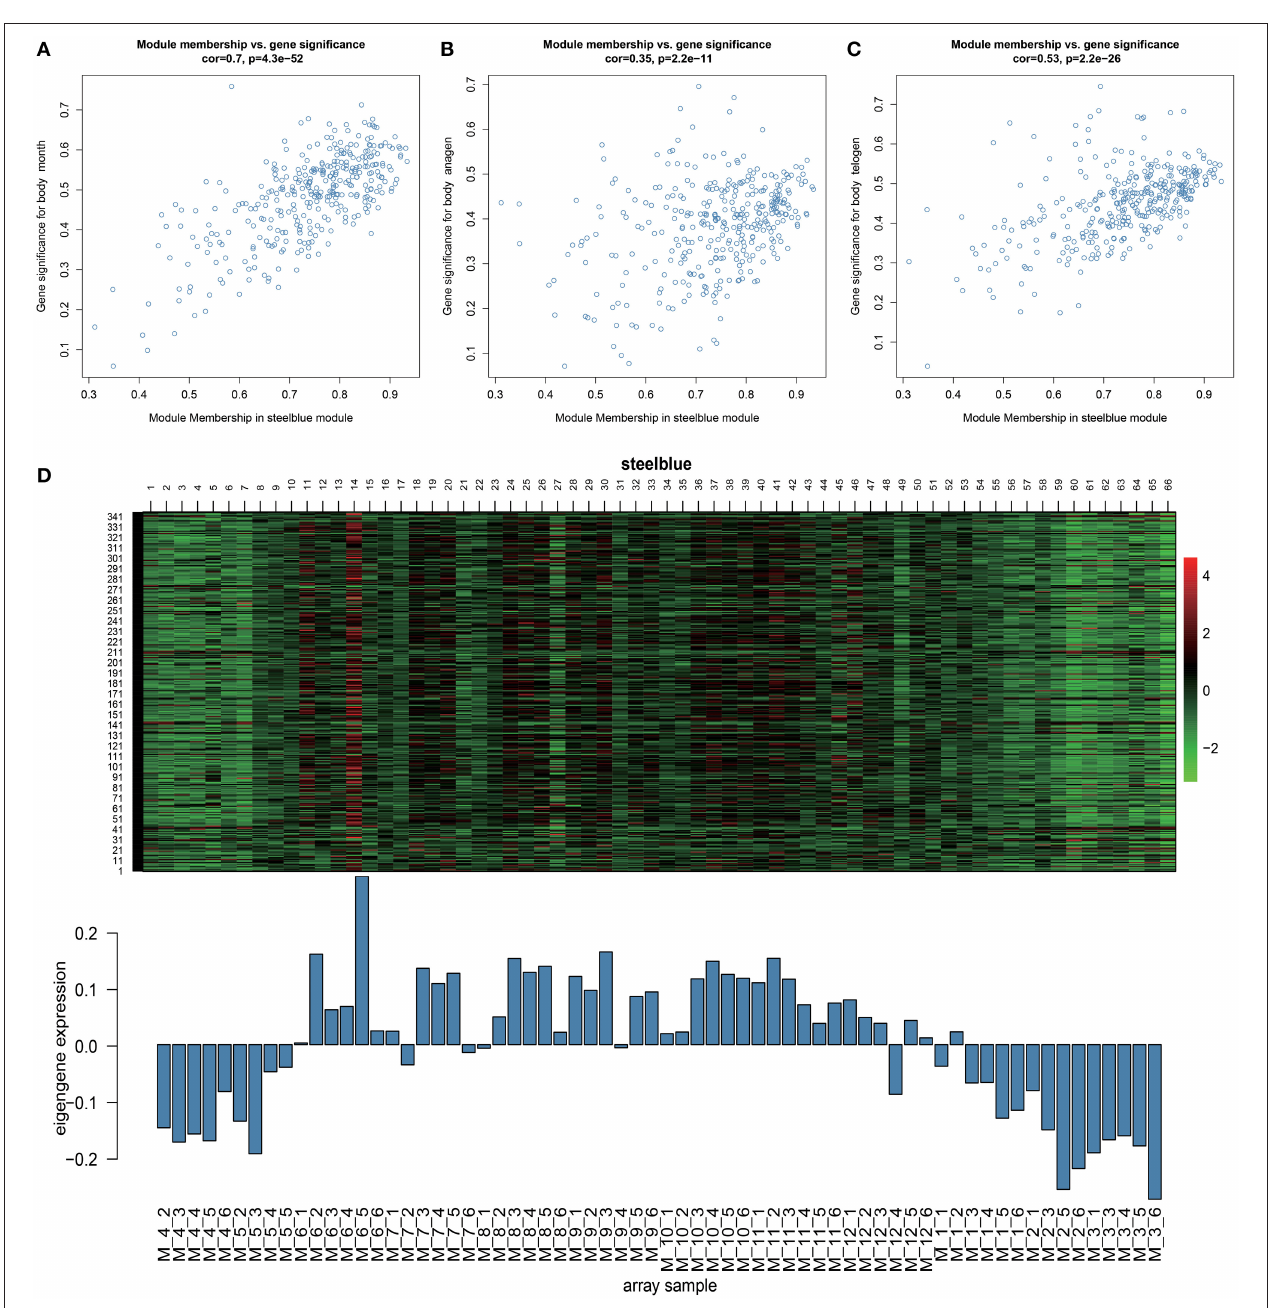
FIGURE 3 | Key module analysis. (A–C) Scatterplot of Gene Significance for Module Membership in steelblue module. (D) Heatmap of steelblue module genes expression pattern. The Abscissa is the sample name, the above picture is the heat map of the expression of the genes in the module in different samples, and the following picture is the expression pattern of the characteristic values of the module in different